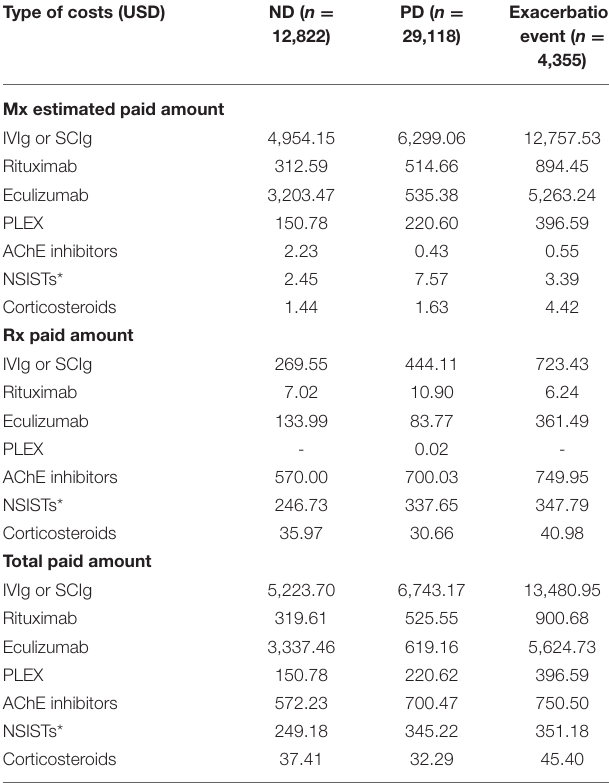
TABLE 6 | Standardized mean 12-month payer-relevant medical and pharmacy service costs per patient in ND, PD, and exacerbation event subgroups.